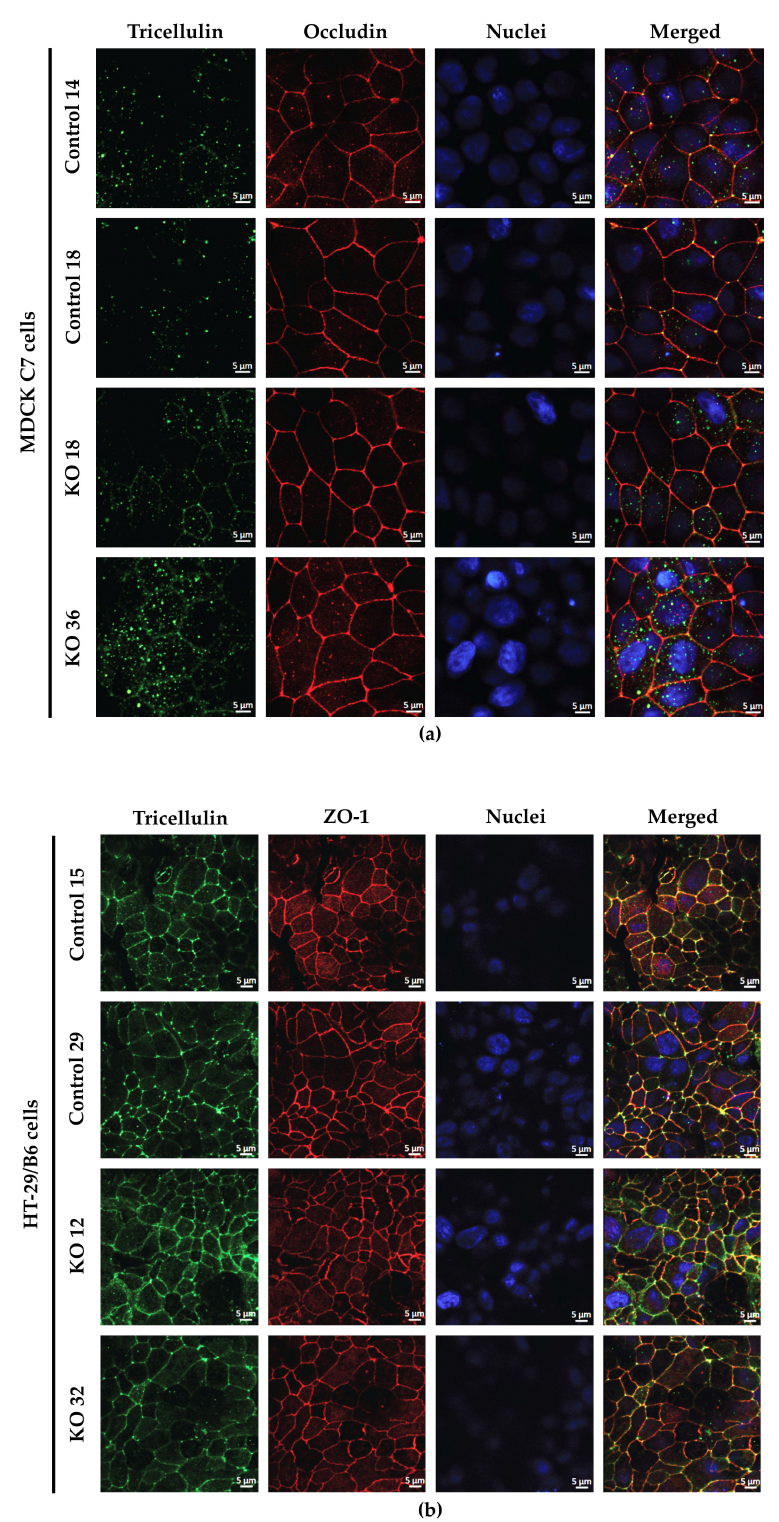
Figure 3. Localization of tricellulin in control and angulin-1 knockout cells. ( a ) Immunostaining of tricellulin in MDCK C7 angulin-1 KO cells. After angulin-1 knockout, tricellulin was still located in the tTJ, but additionally in the bTJ. ( b ) Immunostaining of tricellulin in HT-29/B6 angulin-1 KO cells. After angulin-1 knockout, tricellulin was found in both tTJ and bTJ, similar to control